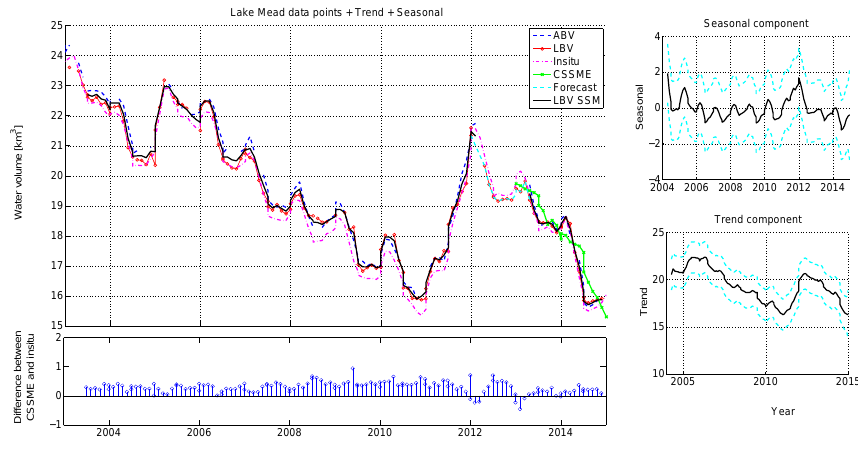
Figure 10. Lake Mead SSM analysis. ( Top left ) The combined SSM estimate (CSSME) (magenta line) and the forecast (green line) for 2013 and 2014; ( Bottom left ) difference between CSSME and in situ observations; ( Top right ) estimated seasonal component; ( Bottom right ) estimated trend component. The dashed cyan lines indicate the upper and lower 95% confidence limit.